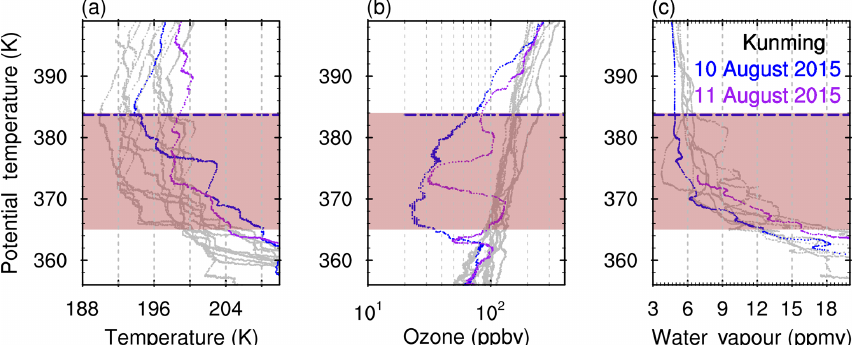
Figure 9. As Fig. 2 but for the case in August